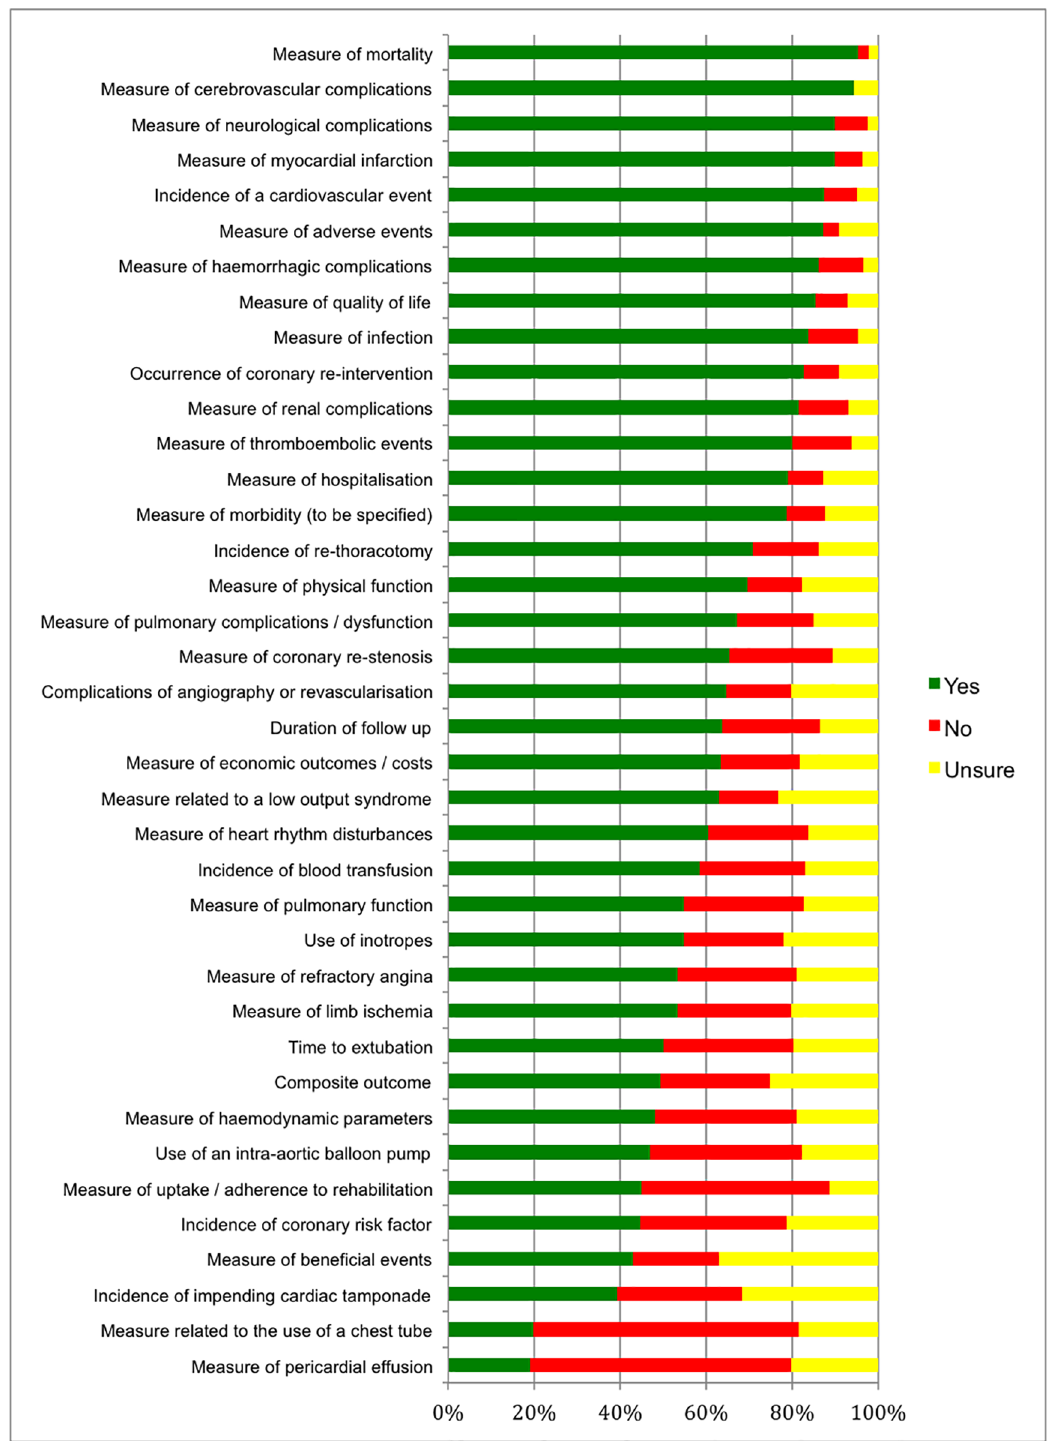
Fig 2. Round 1 of eDelphi: Rating for 38 potential core outcomes.